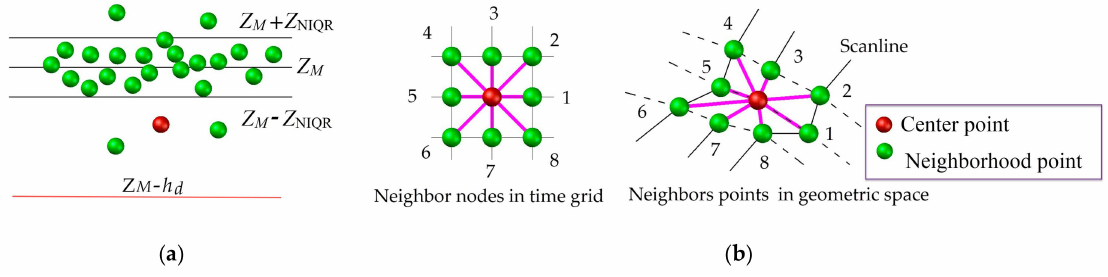
Figure 7. Characteristics of valley points. ( a ) Height feature, and ( b ) gradient e ff ect near crack